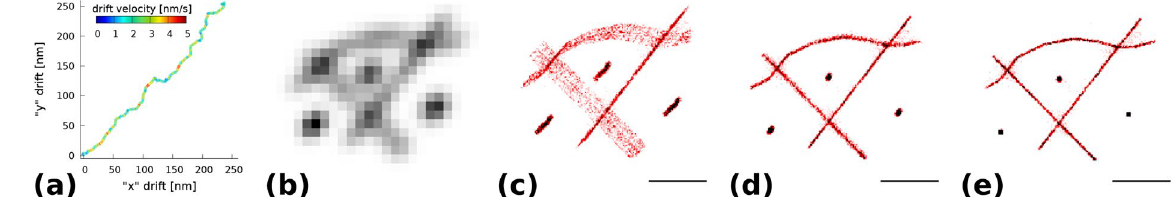
Figure 6. Drift trajectory and velocity ( a ) and its effects, ( b ): conventional image, ( c ): SMLM image without drift correction, ( d ) SMLM image with drift correction, ( e ) ground-true image without drift. Scale bar is 1